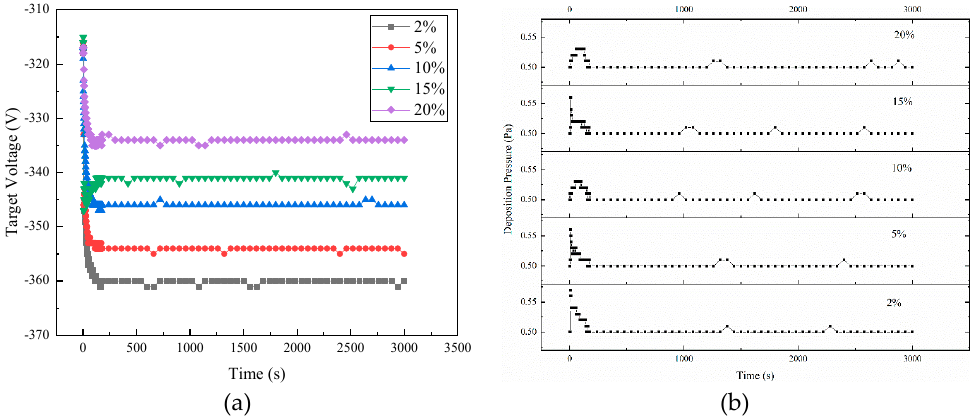
Figure 4. Experimental time-dependent ( a ) target voltages and ( b ) deposition pressures under the PEM system at different set values.